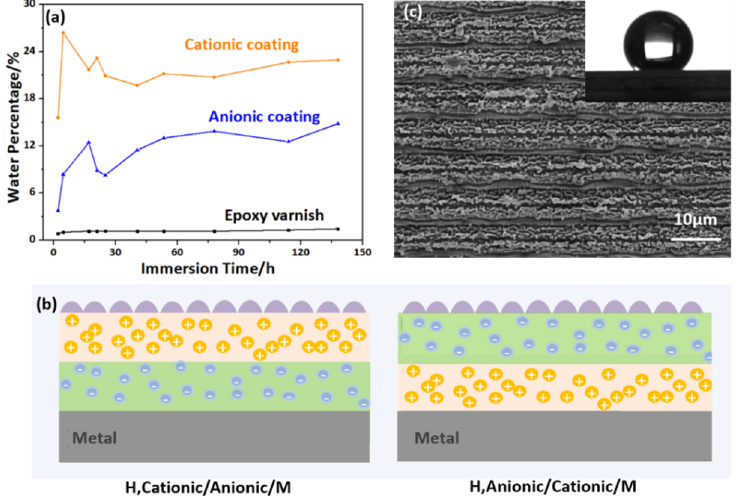
Figure 6. Water absorption property of the coatings, design of bipolar, hydrophobic coatings, and the surface structure of the hydrophobic layer. ( a ) The water uptake with increasing immersing time of the single-polar and epoxy coatings. ( b ) The constructed bipolar, hydrophobic coating systems: hydrophobic, cationic/anionic/metal (H, Cationic/Anionic/M) and hydrophobic, anionic/cationic/metal (H, Anionic/Cationic/M). ( c ) The morphology of the hydrophobic surface with an insert showing the contact angle of a droplet about 139.1°.